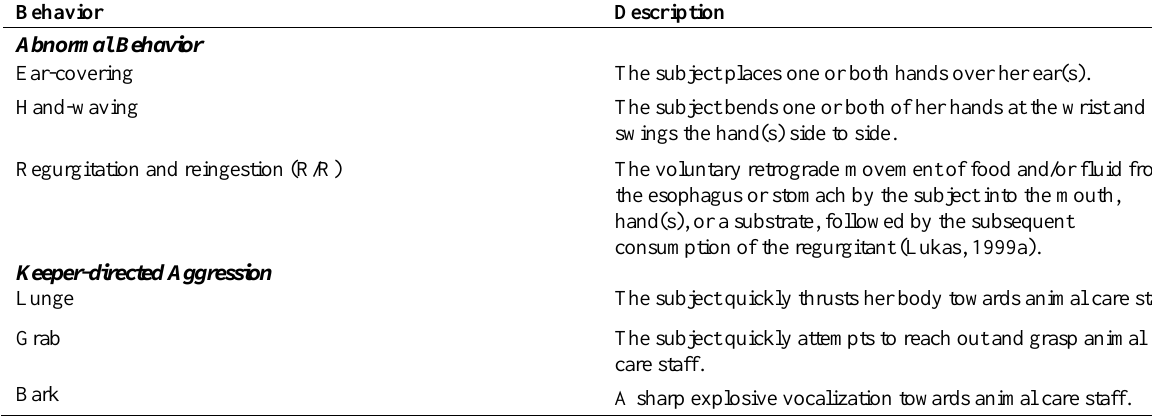
Ethogram of the Subject’s Abnormal and Keeper-Directed Aggressive